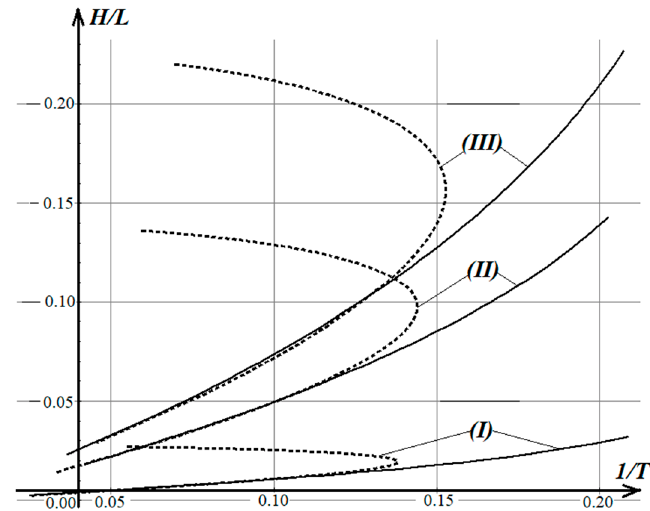
Figure 4. The dependence of the wave steepness (H/L) on the period T : (I) H = 0.1, (II) H = 0.5 and (III) H = 0.8 ; FN model—solid lines, BM model—dashed lines.